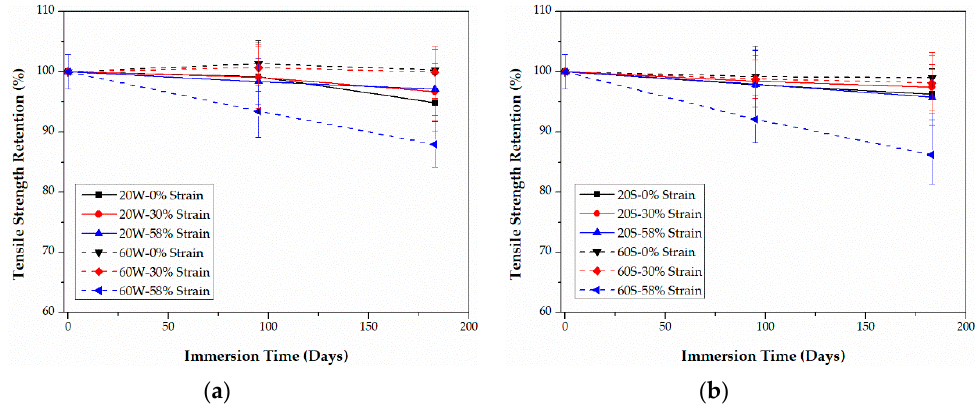
Figure 10. Retention of the tensile strength of PU-based CFRPs immersed in distilled water ( a ) and seawater ( b ) for 6 months, respectively.